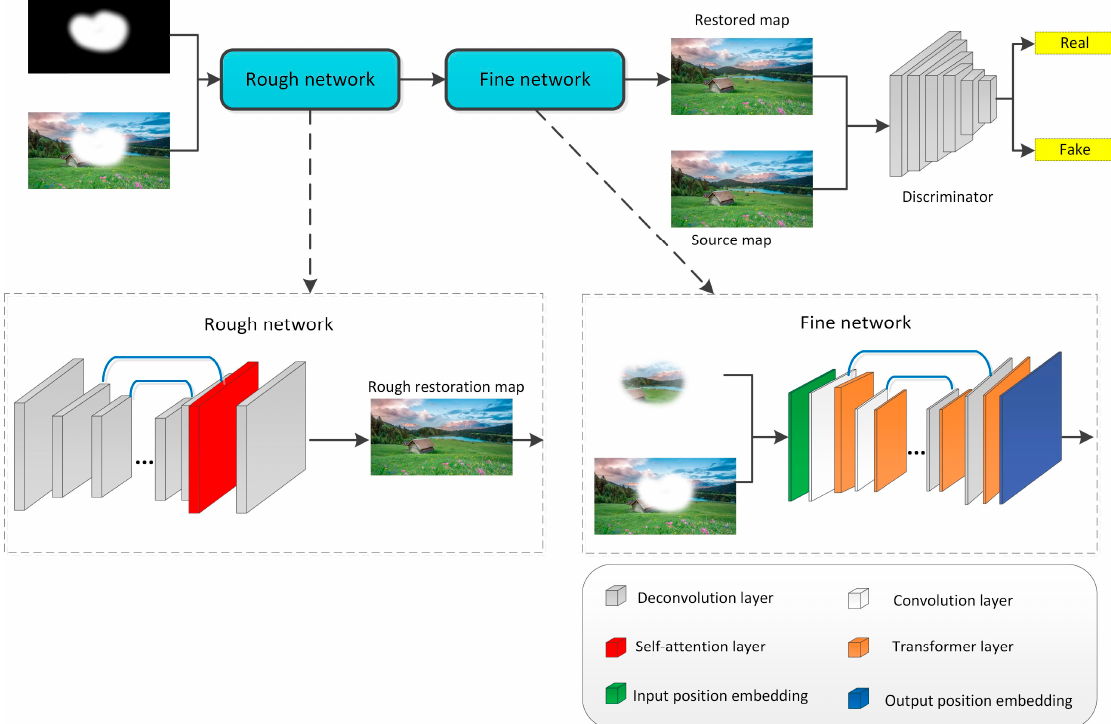
Figure 4. Network structure of the proposed method. The discriminator is a full convolutional network consisting of five convolutional layers. Each convolutional layer is immediately followed by a normalization layer and finally by an activation layer. The role of the discriminator is to distinguish between the generated fake ones and the original true intact image, which is essentially a classification network. The resulting low-quality restored images are marked as false during the training process. The iteration process guarantees that the restored images are close to the real original image in terms of texture and